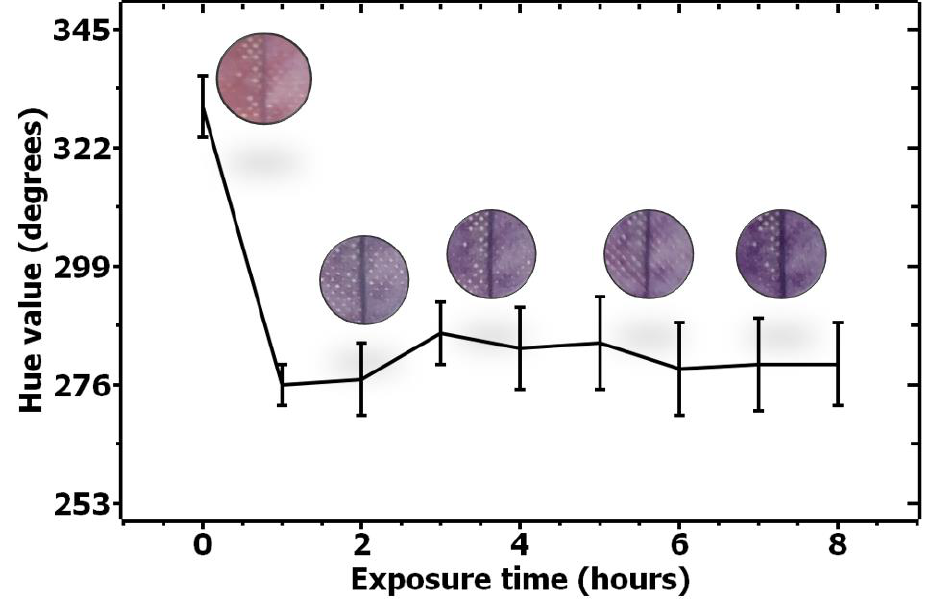
Figure 4. Quantification of color change for acetone-sensitive solution upon exposure to acetone from 0–8 h.